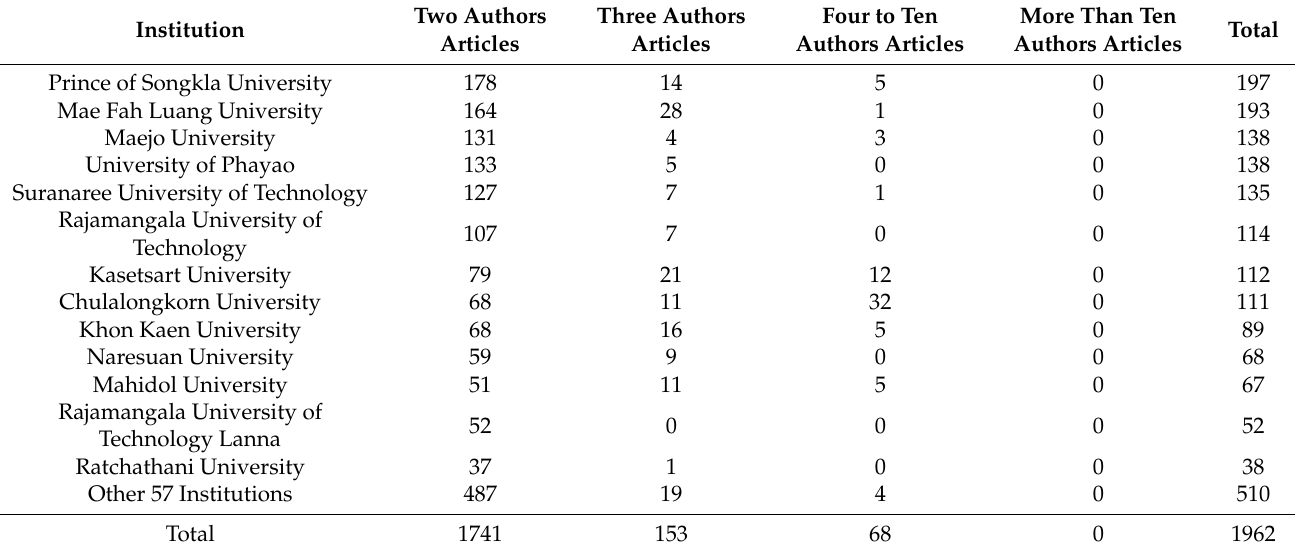
Table 5. Chiang Mai university’s domestic collaboration pattern by